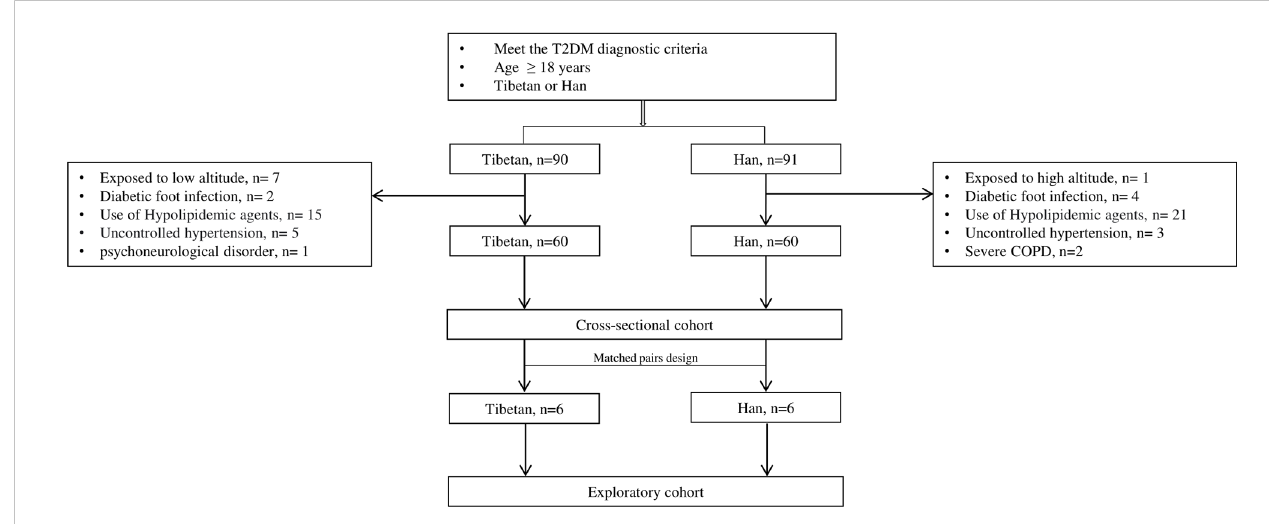
FIGURE 1 Flow chart of patient collection. COPD: chronic obstructive pulmonary